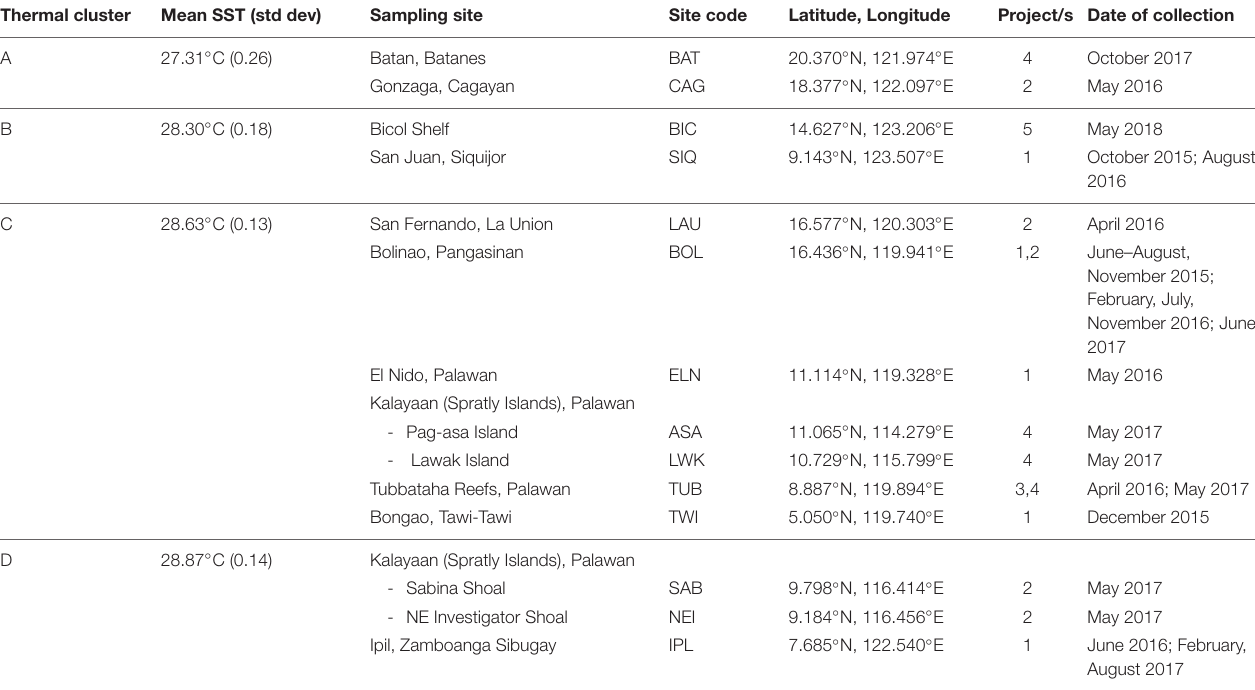
TABLE 1 | Sampling sites, dates of collection, and mean SST per thermal cluster.